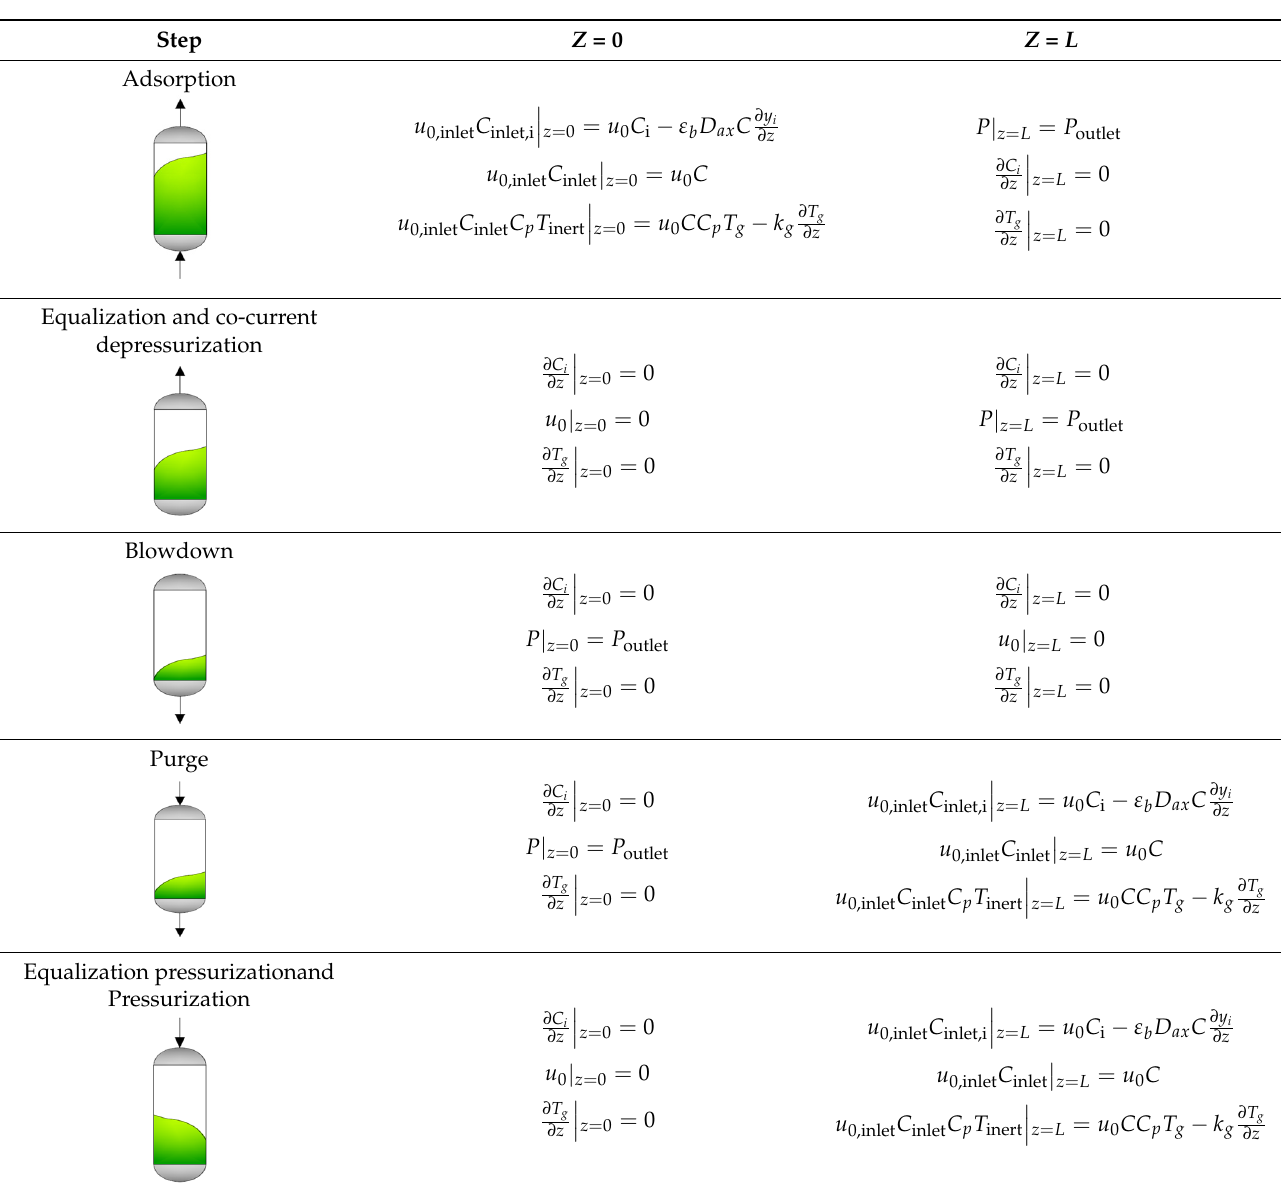
Table 2. Mathematical model of 1D non-isothermal adsorption